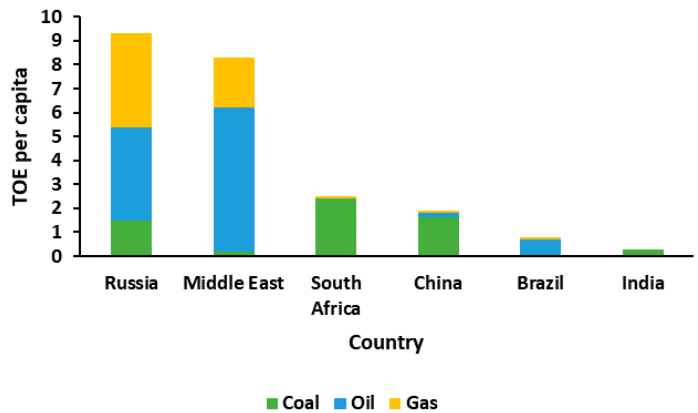
Figure 3. Production of fossil fuel in di ff erent nations along with India [11].